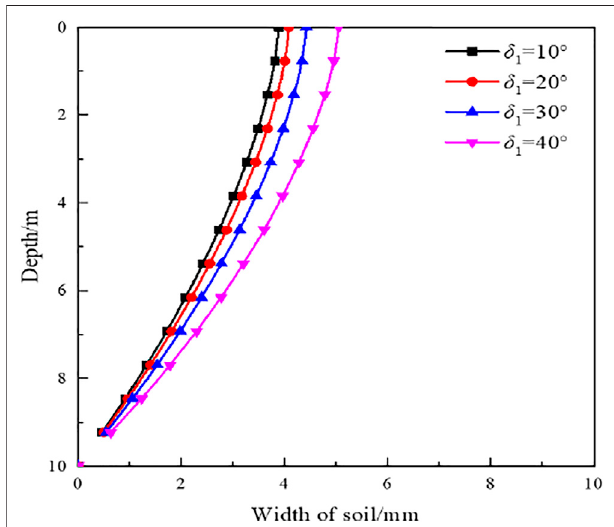
FIGURE 11 | In fl uence of the friction angle between the wall and soil on the slip